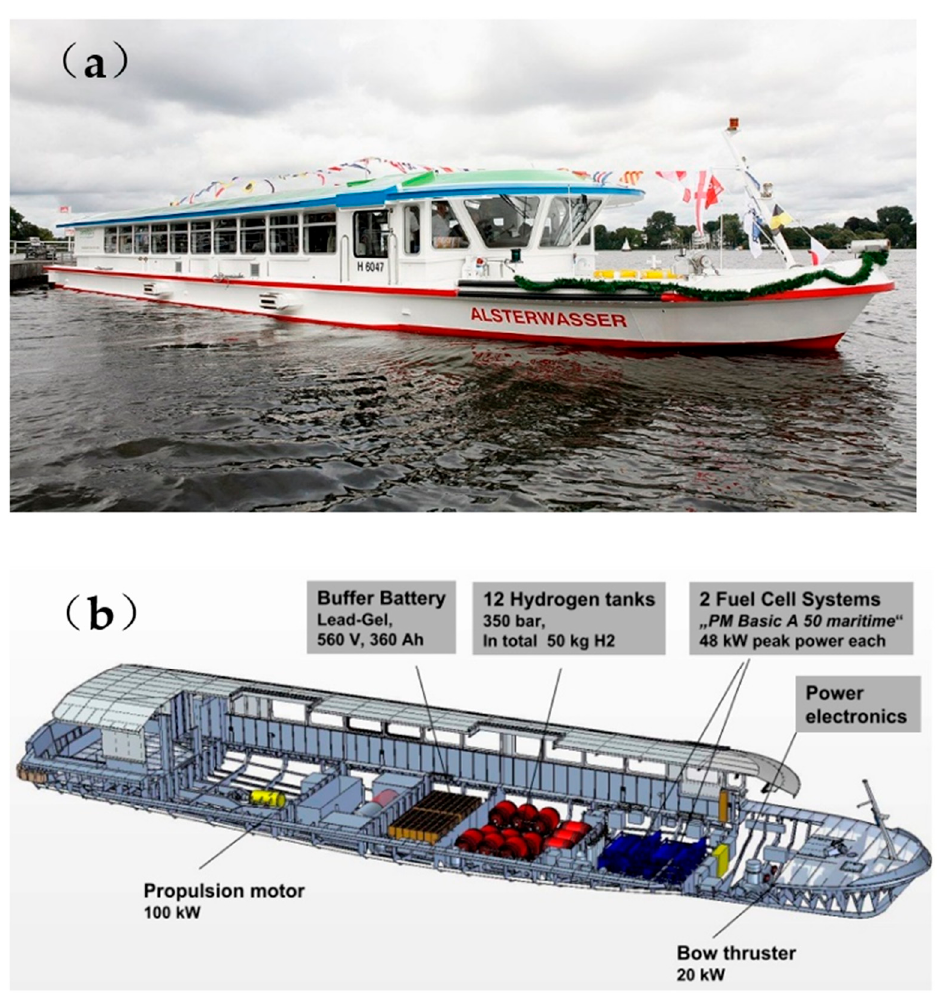
Figure 6. ( a ) The inland-river tourist ship “FCS Alsterwasser” [54]; ( b ) a schematic diagram of the electric propulsion system of “FCS Alsterwasser” [54].